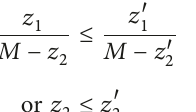
Algorithm 1 computes the Pareto front for the School Prob-